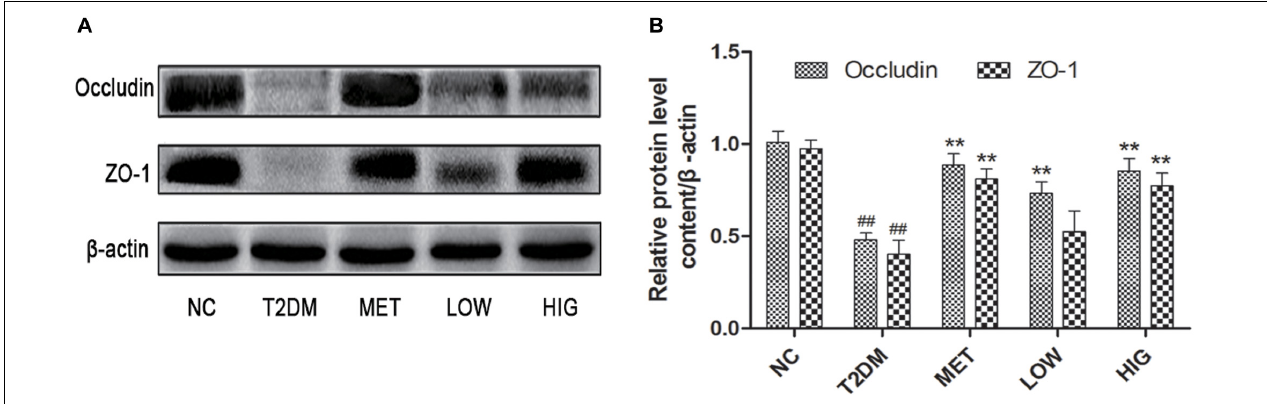
FIGURE 4 | Effects of RAGP on the expression level of ZO-1 and occludin in the ileum tissues in each group ( n = 6). (A) The expression levels of ZO-1 and occludin were analyzed by western blotting. (B) The density identification of occluding, ZO-1 were calculated as shown. Values are mean ± SD, # P < 0.05, ## P < 0.01 vs.